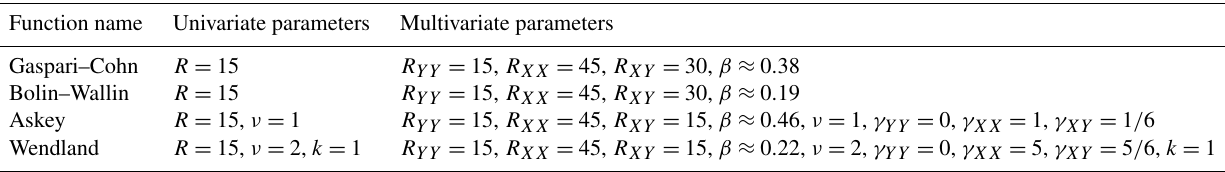
Table 3. Localization parameters for the experiment observing only the small process. Note that weakly coupled parameters are not shown in this table because they are exactly equal to the multivariate parameters, except with β =